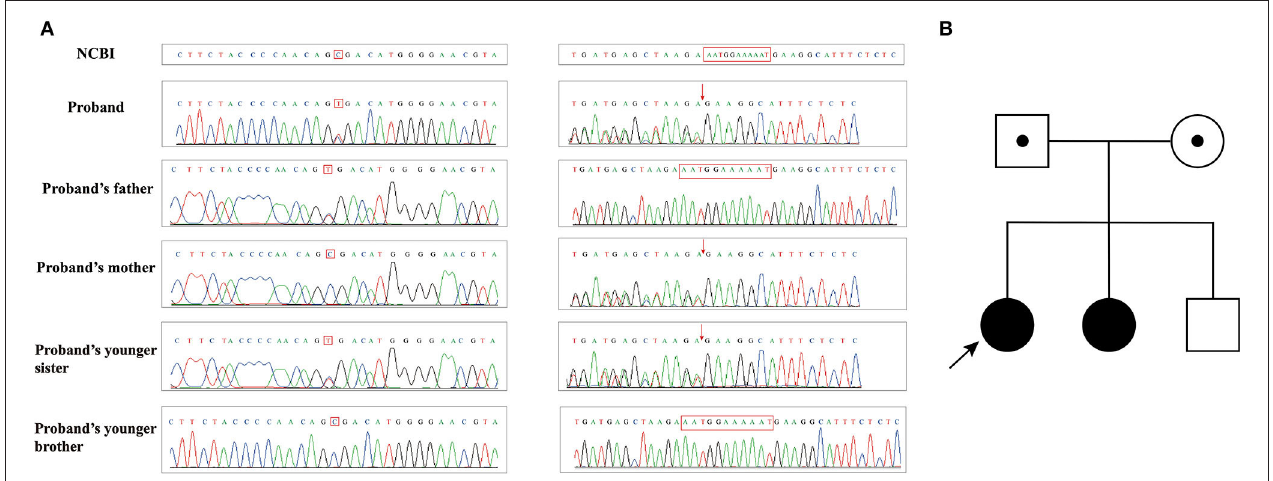
FIGURE 4 | (A) Sanger sequencing results of family I; (B) Pedigree of family I.